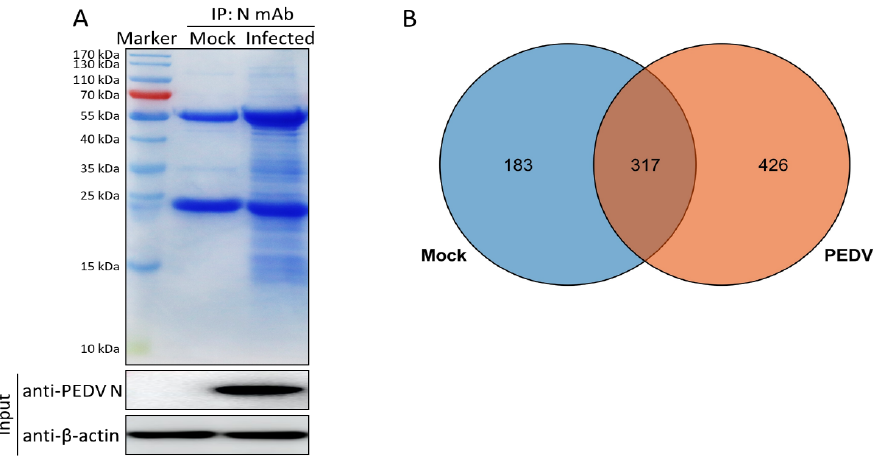
Figure 1. Identification of PEDV N protein-interacting cellular proteins. ( A ) Mock-infected Vero cells or cells infected with PEDV at a MOI of 0.5 were harvested at 24 hpi, and a co-immunoprecipitation assay was performed. Purified anti-N IgG. PEDV N-bound host proteins were eluted and analyzed via SDS-PAGE followed by Coomassie blue staining. Lane 1, protein molecular weight ladder; lane 2, mock-infected; lane 3, PEDV-infected. ( B ) Venn diagram of the characterized protein candidates binding to the PEDV N protein from mock-infected, and PEDV-infected cells, respectively. Blue and orange colors indicate proteins from the mock-infected, and PEDV-infected cells, respectively. Common proteins within the data sets are shown in the colored intersections. Proteins were presented as their respective NCBI gene names (Supplementary Table S1).